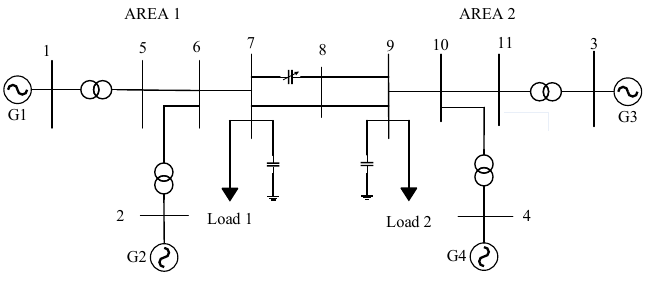
Figure 6. Network of the 2-area 4-machine (2A4M) system.